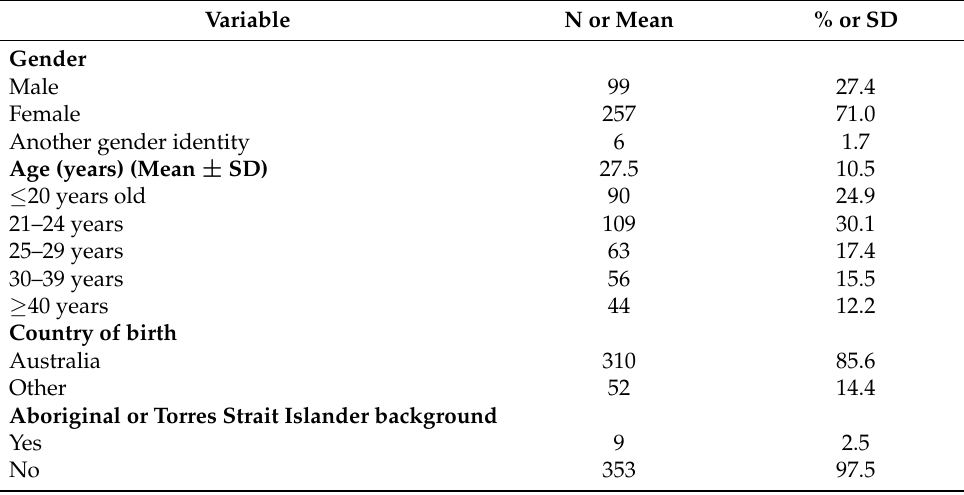
Table 1. Demographic characteristics of an Australian university student sample ( n =